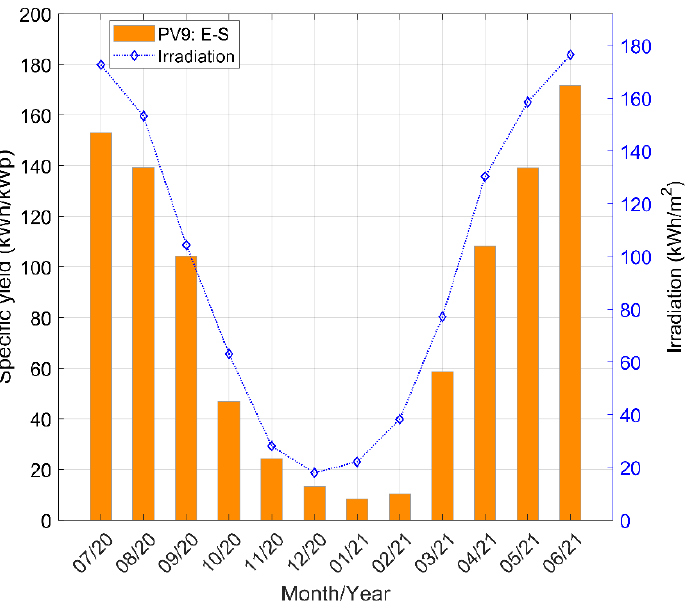
Figure 7. Monthly specific yield of the PV9 roof installation. Irradiation was computed for 2005–2020 using PVGIS 5.2.